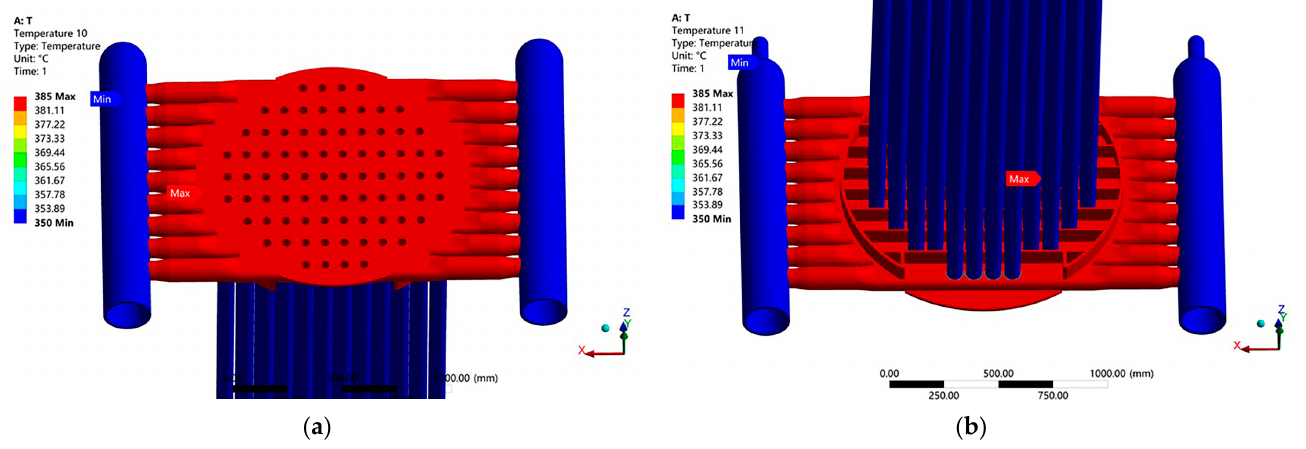
Figure 3. ( a ) Temperature distribution in the upper flat-round tubesheet. ( b ) Temperature distribution in the lower flat-round tubesheet.